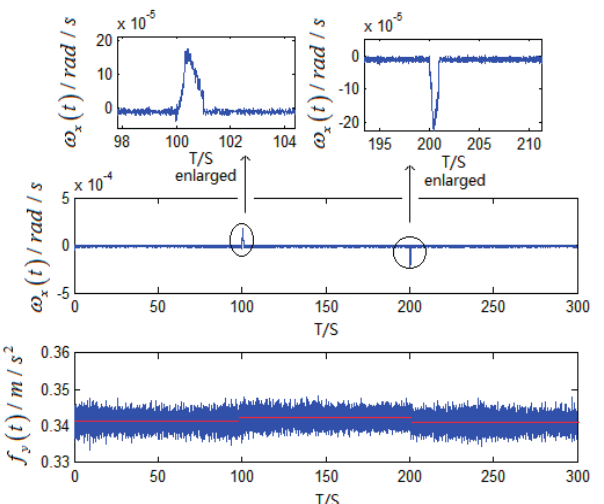
Figure 4. The outputs of gyro and accelerometer with the interference of small angular motions.